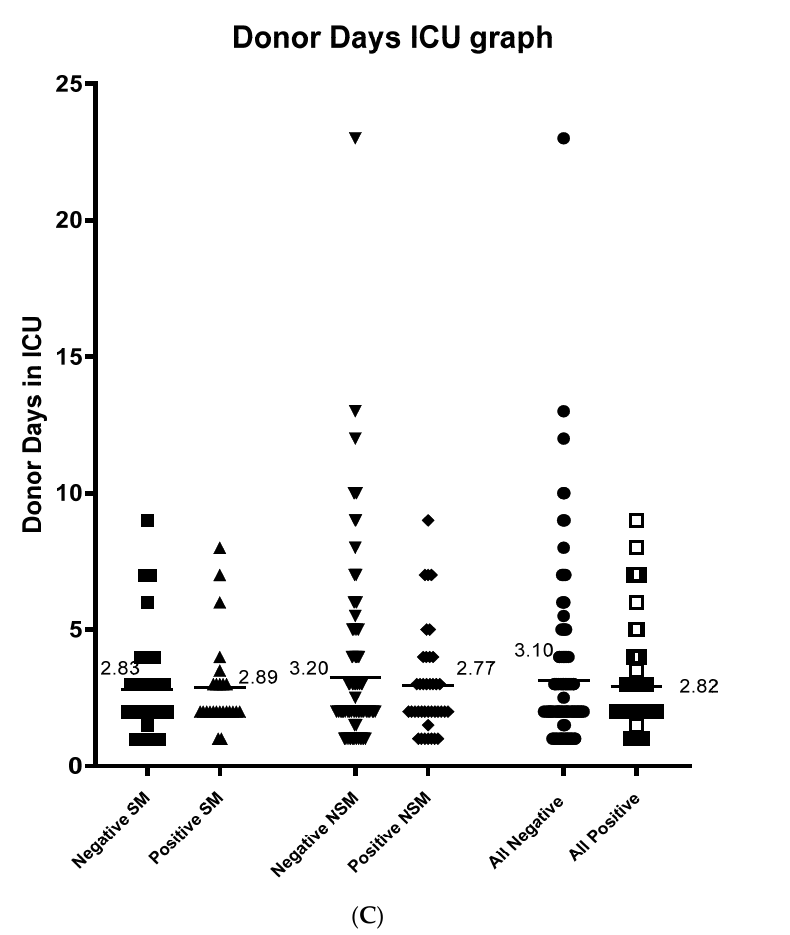
Figure 3. ( A ). Scatter plot of donor age outcomes. The age of the donor at time of donation in years is shown for each analysis group, the mean of each group is marked and labelled. Negative local ( n = 79), positive local ( n = 33), negative non-local ( n = 142), positive non-local ( n = 43), all negative ( n = 221), all positive ( n = 76). ( B ). scatter plot of donor BMI outcomes. The BMI as calculated from height and weight of the patient is shown for each analysis group, the mean of each group is marked and labelled. Negative local ( n = 79), positive local ( n = 33), negative non-local ( n = 142), positive non-local ( n = 43), all negative ( n = 221), all positive ( n = 76). BMI was statistically significant between negative and positive groups ( p = 0.0004). ( C ). Scatter plot of donor ICU outcomes. The amount of time in days that the donor spent in ICU is shown for each analysis group, the mean of each group is marked and labelled. Negative local ( n = 52), positive local ( n = 25), negative non-local ( n = 129), positive non-local ( n = 39), all negative ( n = 181), all positive ( n = 64). Table 2. Cause and mechanism of donor death statistics. The number of each cause or mechanism that had a negative or positive isolation outcome is compared with the percent of each total. ‘Other causes’ or ‘other mechanisms’ have the highest positive results with a significant p value, while those with anoxia or cardiac arrest have the least. Sharp injury and seizure as a mechanism of death have the lowest numbers. However, total numbers in these groups are very low. Outcome (N) % Positive p Value Cause of Donor Death Negative Positive Anoxia/Cardiac Arrest